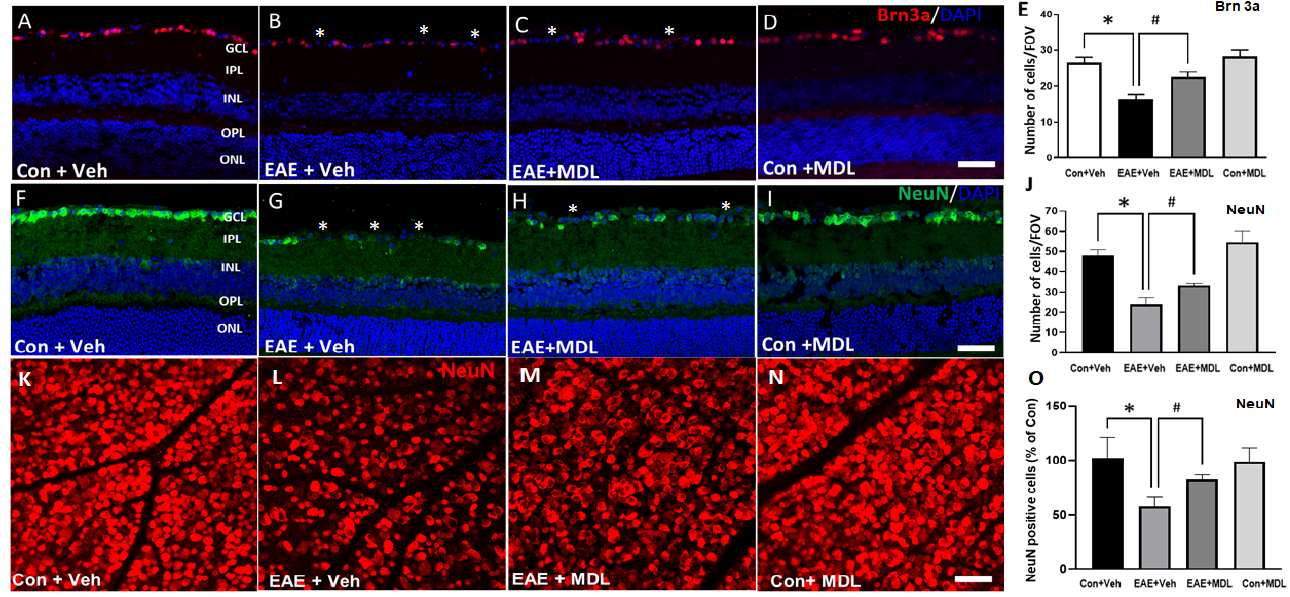
Figure 3. SMOX inhibition protected against RGC loss in the EAE retina. Representative confocal images showing the immunolabeling of retinal cryostat sections with Brn3a ( A – D ) and NeuN ( F – I ). Quantitative analyses demonstrated a significant loss of Brn3a-positive ( E ) and NeuN-positive ( J ) cells in the GCL in response to EAE induction. MDL 72527 treatment significantly protected against the EAE-induced RGC loss. Data are presented as mean ± SD. * ( p < 0.01); # ( p < 0.05). n = 6–7 per group. Scale bar: 50 μ m. Asterisks (*) indicate areas of cell loss. Scale bar: 50 μ m. GCL, ganglion cell layer; INL, inner nuclear layer; IPL, inner plexiform layer; ONL, outer nuclear layer; OPL, outer plexiform layer. ( K – N ): Representative confocal images of retinal flatmounts immunostained using NeuN antibody showing loss of RGCs in EAE retina and the improved protection offered by MDL 72527 treatment. Quantification study ( O ) performed using NIH ImageJ demonstrates significant loss of NeuN positive cells in Veh EAE retina and a significant survival in response to MDL 72527 treatment. Data are presented as mean ± SD. * p < 0.01; # p < 0.05. n = 6–7 per group. Scale bar: 50 μ m.